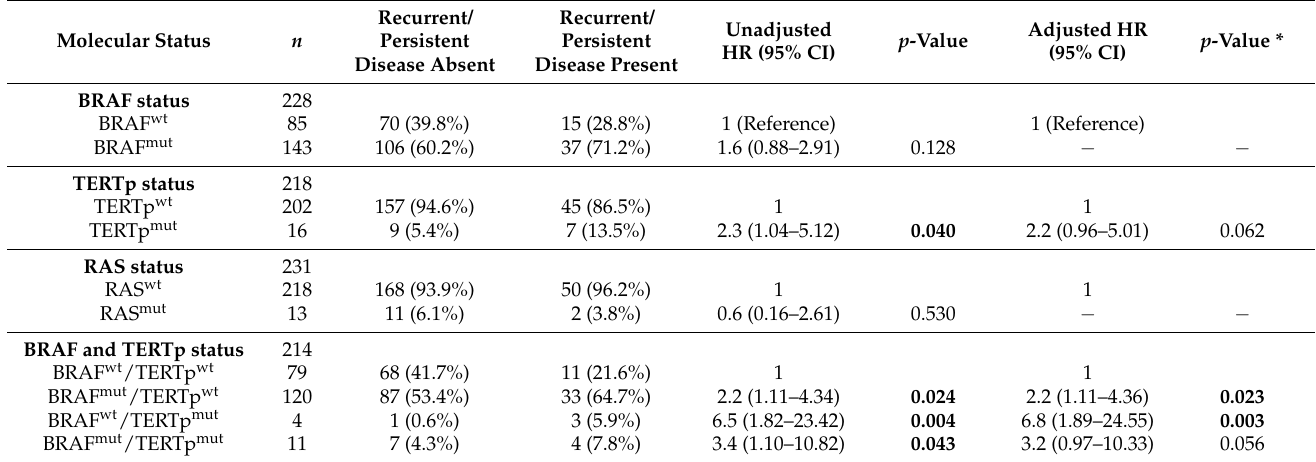
Table 3. Analysis of molecular status in the risk of recurrent/persistent disease.